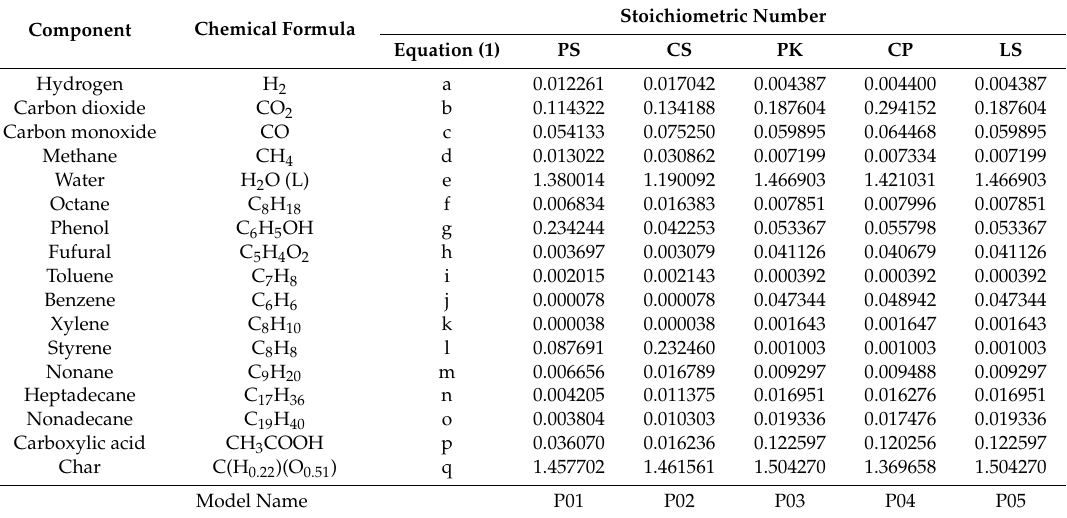
Table 2. The optimum set of stoichiometric numbers for decomposition reaction of biomass generated from the simulation